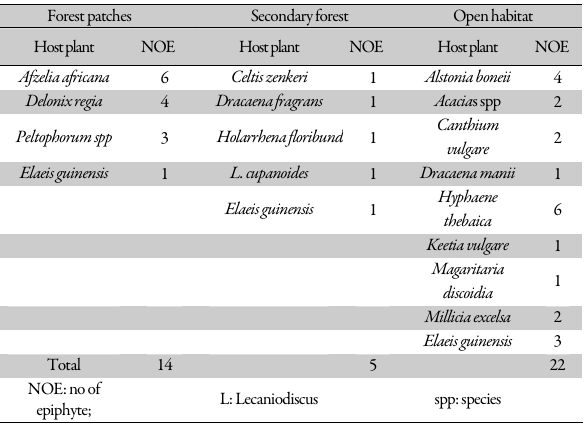
Tab. 1. Composition and distribution of host and epiphytes across the study locations at the Obafemi Awolowo University, Ile-Ife, Nigeria